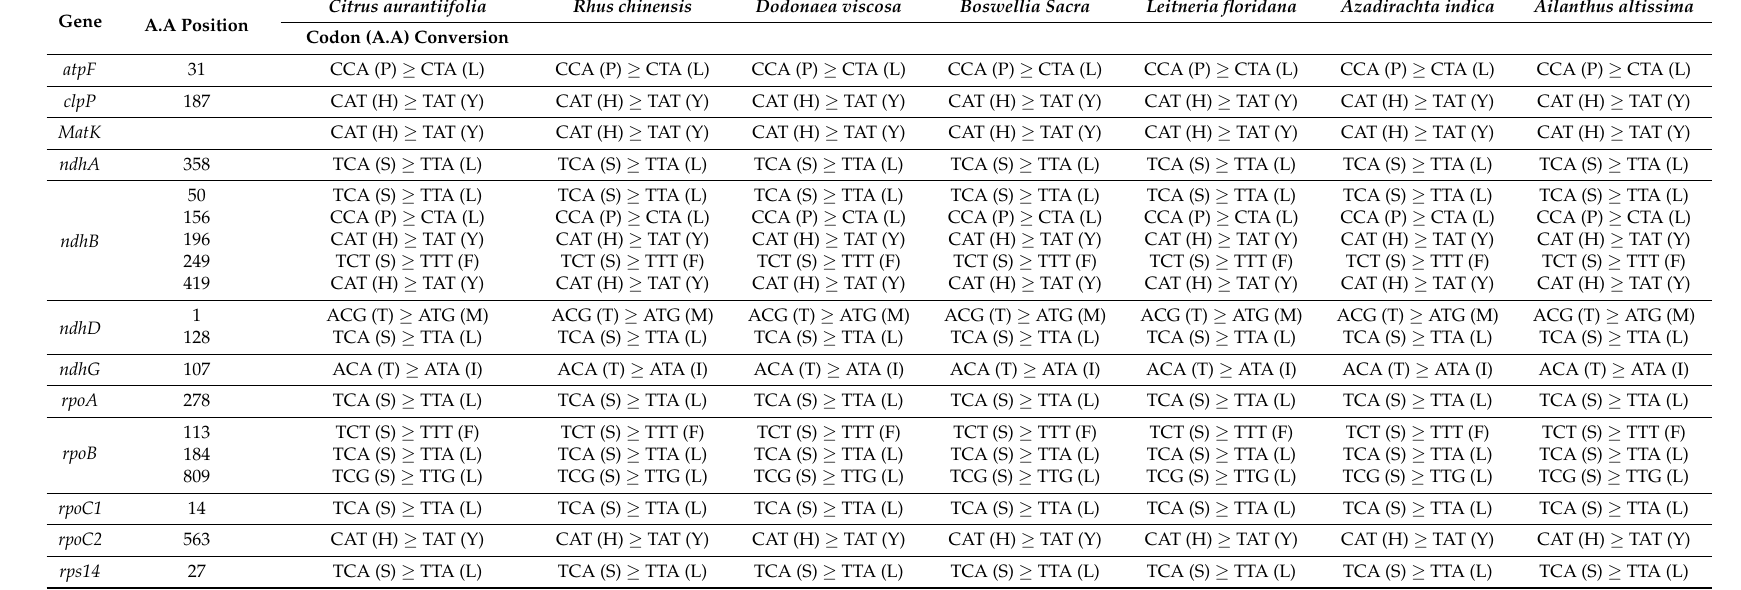
Table 3. List of RNA editing sites shared by the seven plastomes predicted by PREP